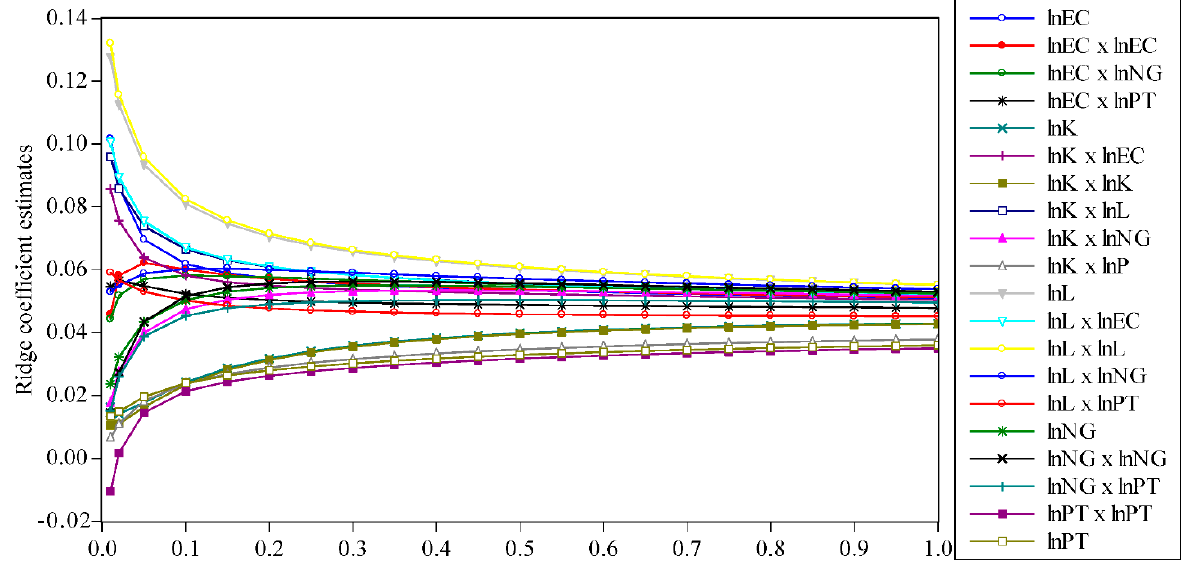
Figure 3. Ridge trace plot based on k values starts from [0.0–1.0]. Table 2. Outcomes of ridge regression estimate when k = 0.65.